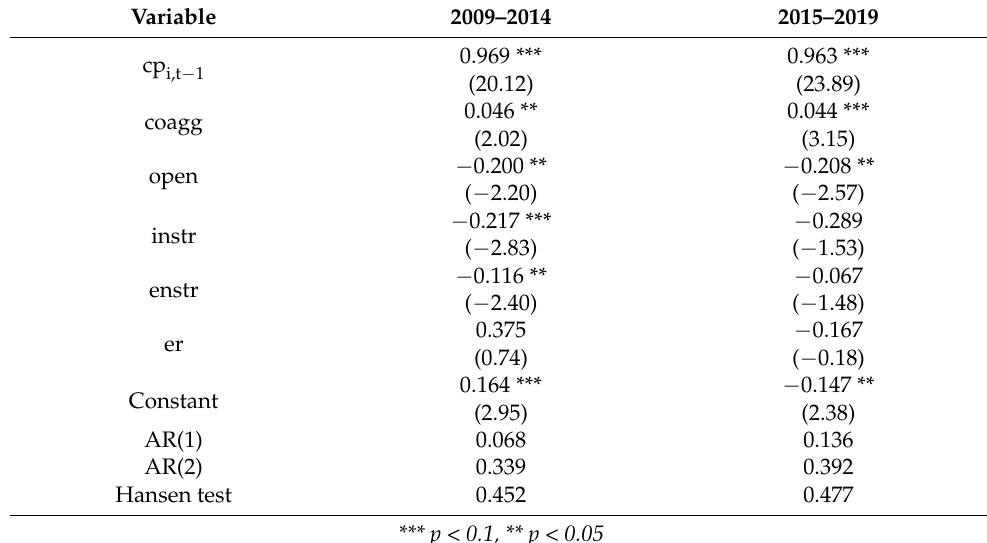
Table 4. Regression results